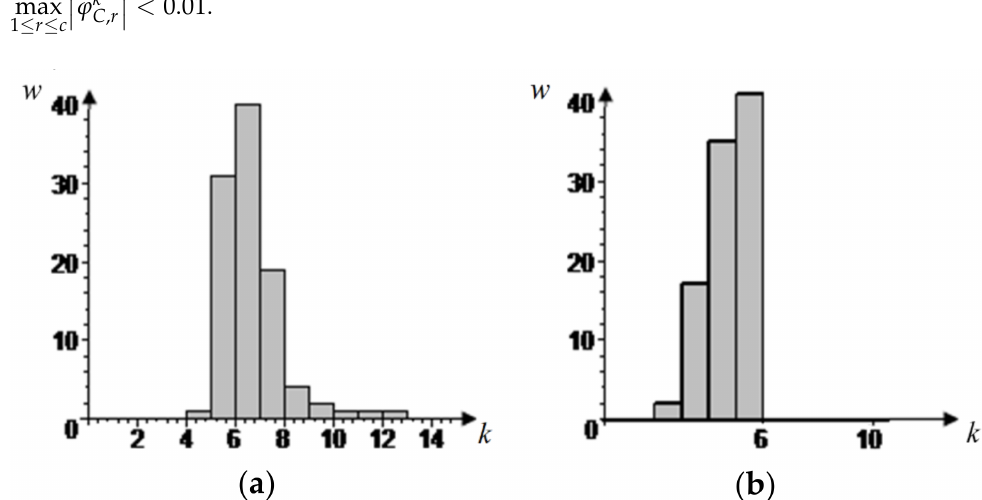
Figure 6. The number of calculated conditions w (%) under which the problem is solved in k iterations for: ( a ) MNM; ( b )